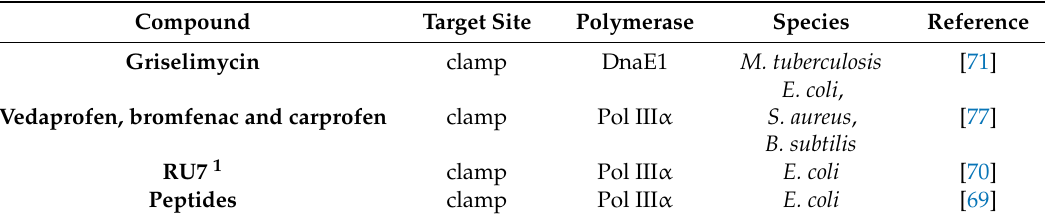
Table 3. Disruptors of polymerase interaction.